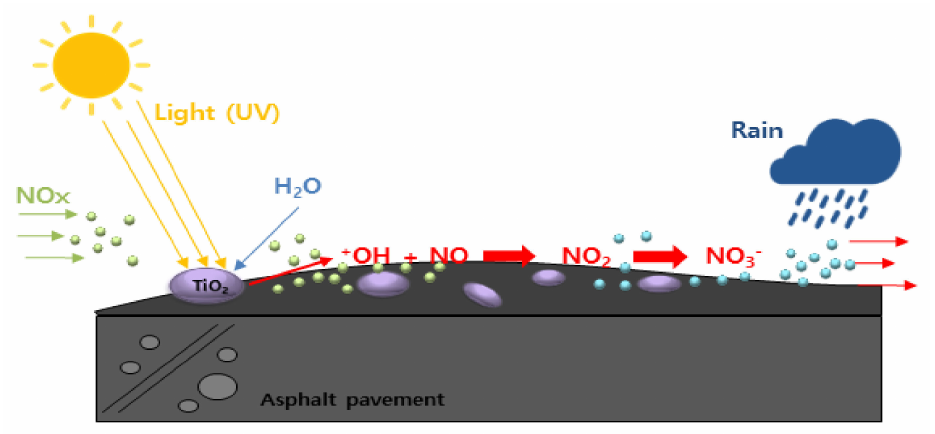
Figure 1. Image of NOx decomposition by TiO